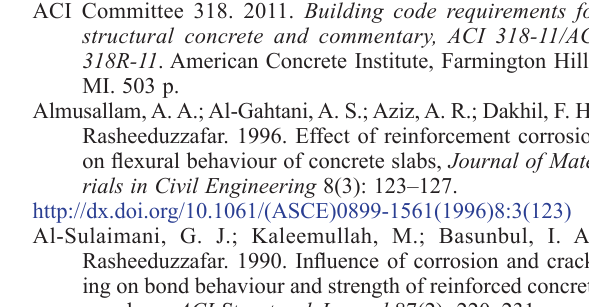
Fig. 14. Variation of reduction in shear capacity with shear span to depth